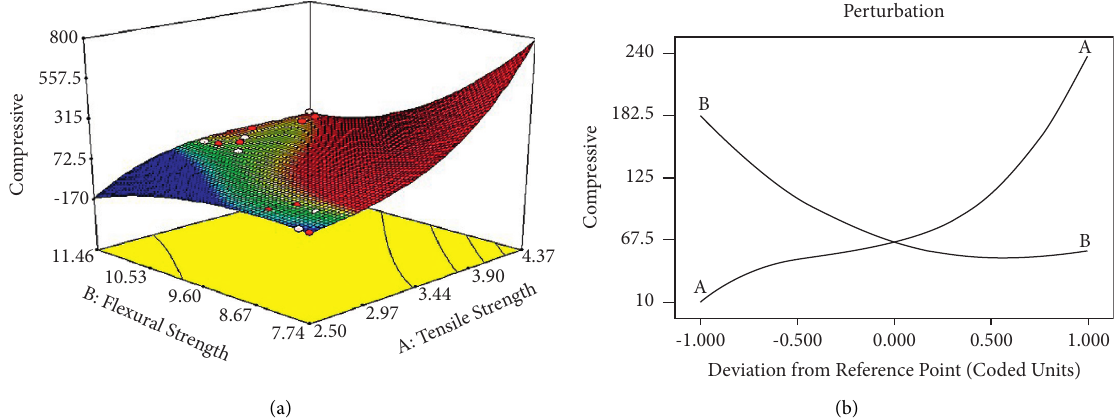
Figure 27: Response surface plots (a) and perturbation plots (b) indicating the relationship between compressive, flexural, and splitting tensile